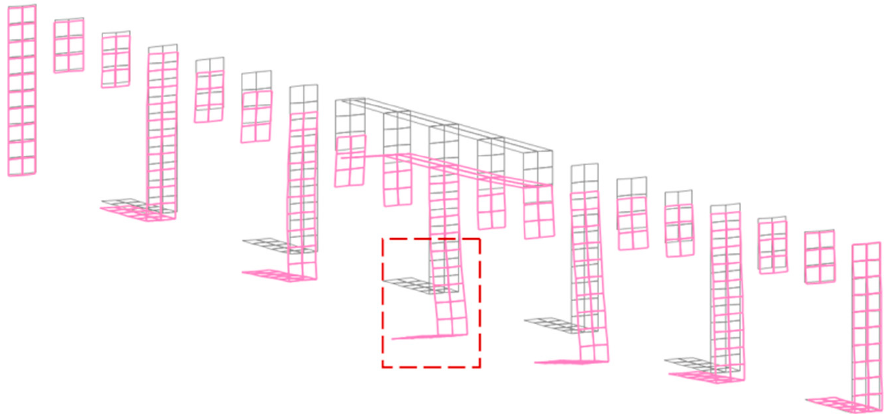
Figure 5. Deformed shape of the heavy duty riveted grating [10].